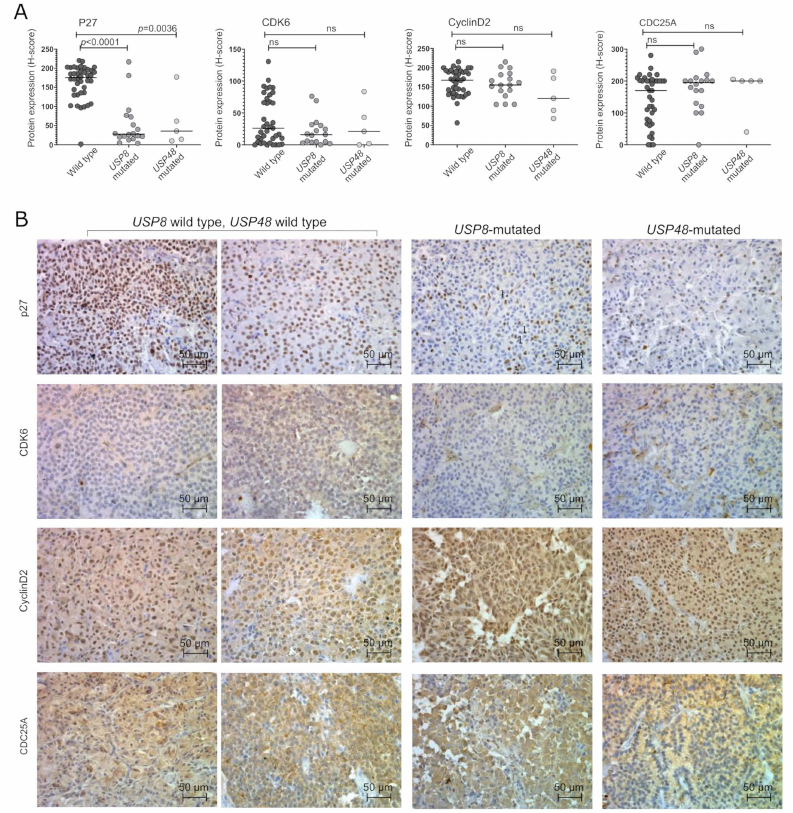
Figure 2. Expression of cell cycle-related proteins in corticotroph PitNETs stratified according to deubiquitinase gene mutations; ( A ). The results of the quantification of immunoreactivity; ( B ). The examples of staining